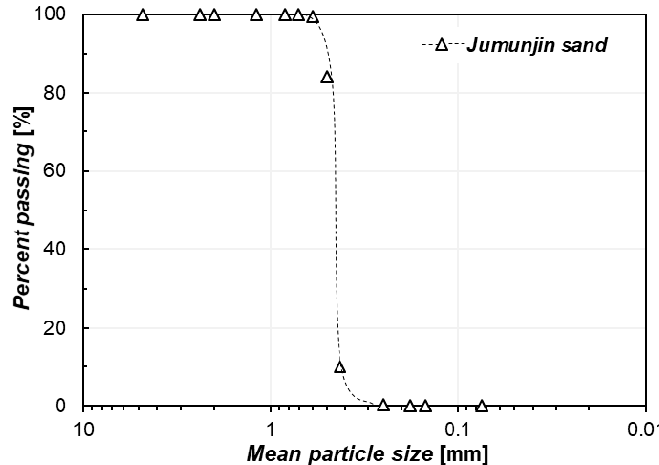
Figure 1. Particle size distribution of jumunjin sand. Table 1. Properties of sand used in this study .